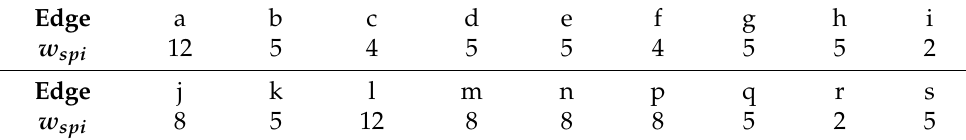
Figure 5. Examples of graphs with the best transmission properties (“best graphs”). Table 9. Distribution of w spi